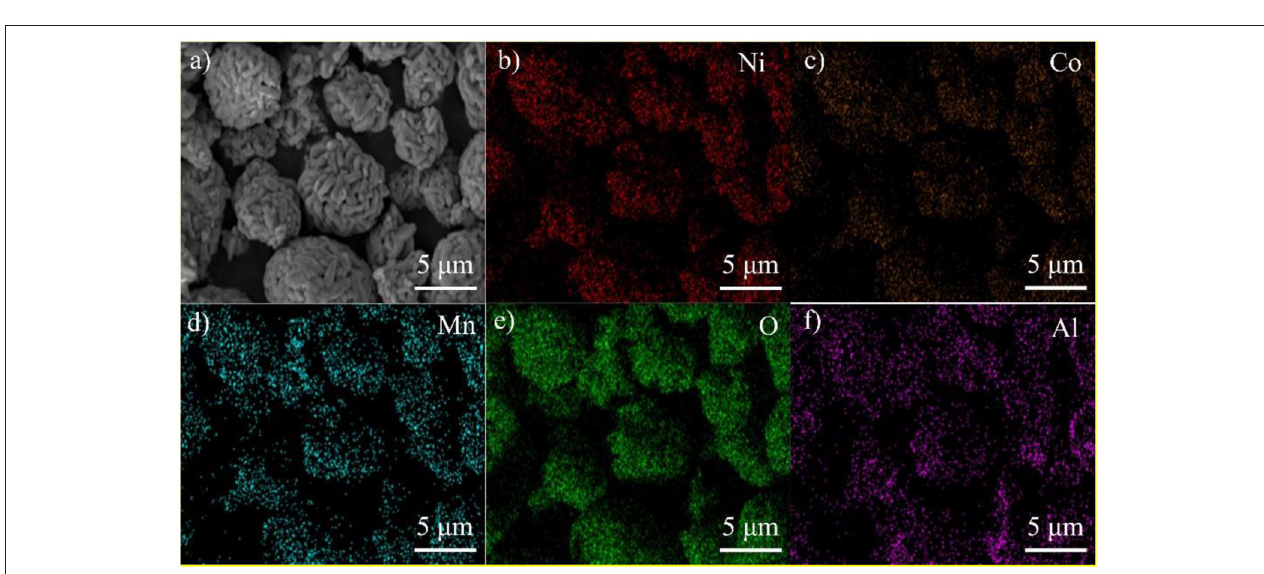
FIGURE 3 | EDS maps for PLA-1-Al 2 O 3 @LNCM: (a) SEM image PLA-1-Al 2 O 3 @LNCM powders, corresponding elemental mappings images of (b) Ni, (c) Co, (d) Mn, (e) O, and (f)